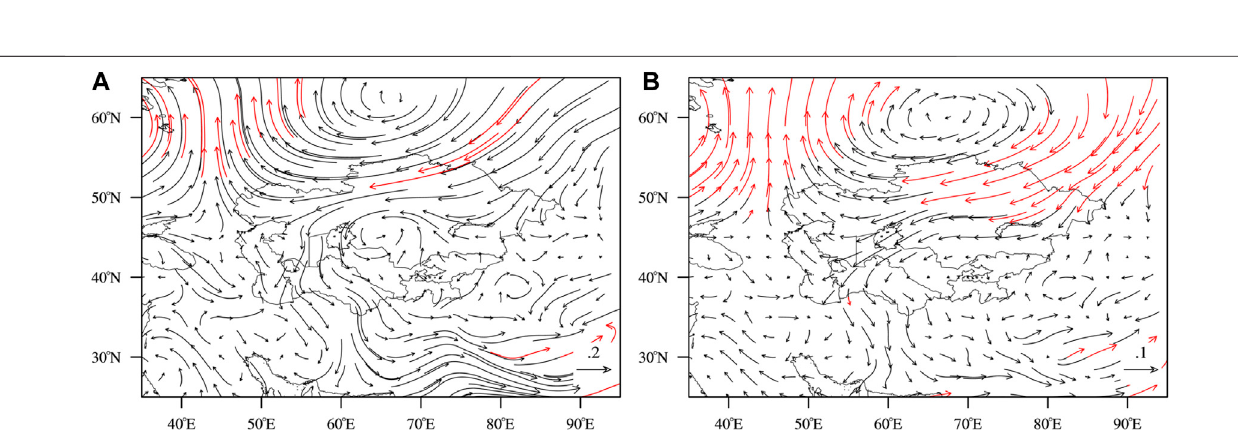
FIGURE 6 | (A) Difference in the water vapor transport in the lower troposphere between the maximum and minimum TP monsoon index years. (B) Regression coef fi cientdistributionoftheTPmonsoonindexforwatervaportransportinthelowertroposphere.Theredwind fi eldin (A,B) istheareathatpassedthe90%con fi dence level student ’ s